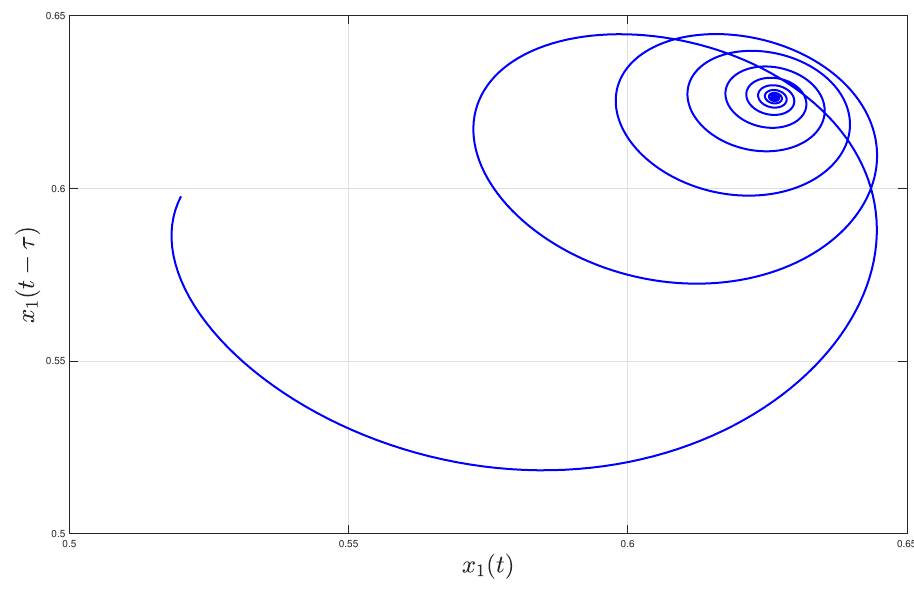
Figure 3. Phase diagram of x 1 ( t ) with 0.4 = τ < τ ∗ = 0.5303, the system is stable.